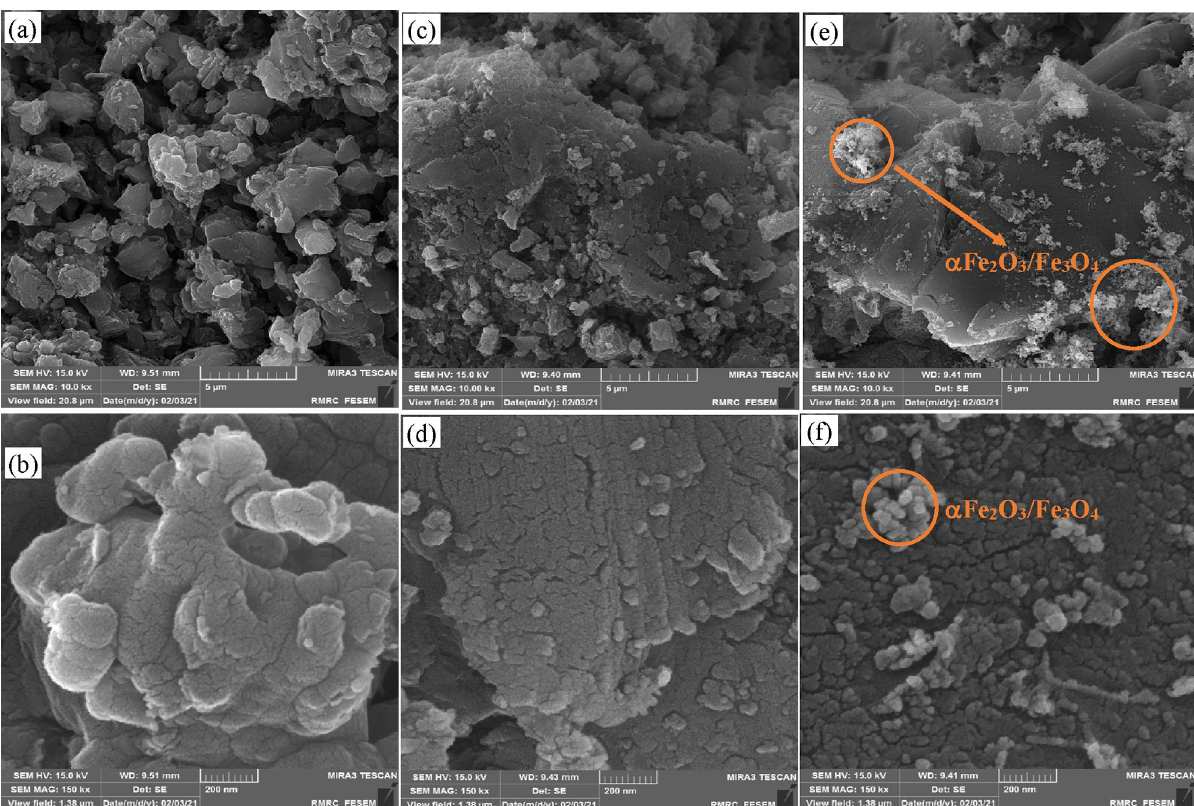
Figure 2. SEM and images of ( a and b ) g-C 3 N 4 , ( c and d ) X2.5, and ( e and f ) X5